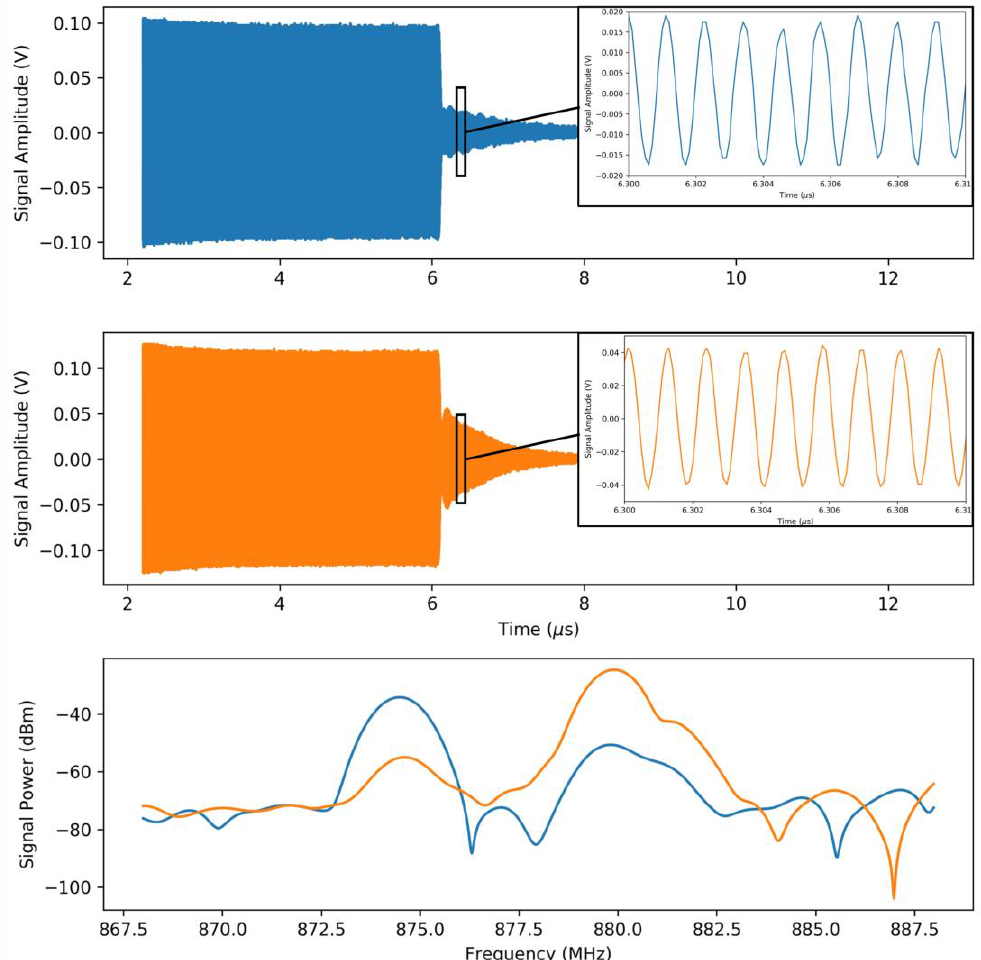
Figure 11. Excitation signal and sensor response, as measured by the receiving antenna, for the 874.7 (top) and 879.7 MHz (middle) modes. The FFT of the two signals are superimposed and shown in the bottom panel.